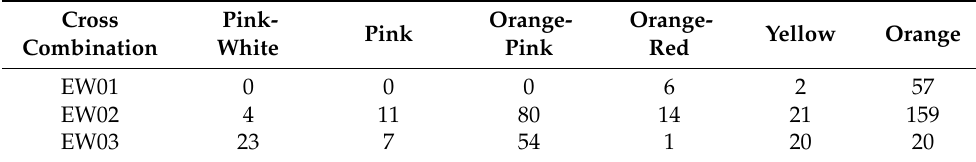
Table 2. The flower color segregation of F1 plants for three cross combinations.